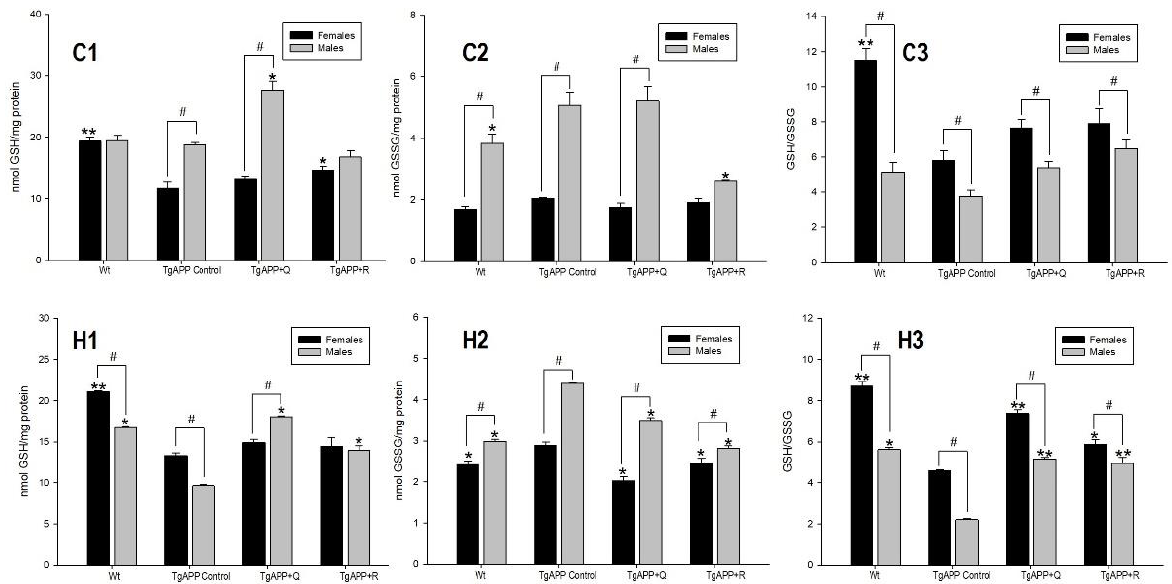
Figure 2. Effect of quercetin (Q) and rutin (R) on GSH (C1, H1), GSSG (C2, H2), and GSH/GSSG (C3, H3) levels. Cortex (C) and Hippocampus (H) (1) WT; (2) TgAPP control; (3) TgAPP + Q; (4) TgAPP + R. * p < 0.05 or ** p < 0.001 vs. TgAPP control (ANOVA followed by the post-hoc Newman – Keuls multiple comparison test); # p < 0.05 (Student t -test).